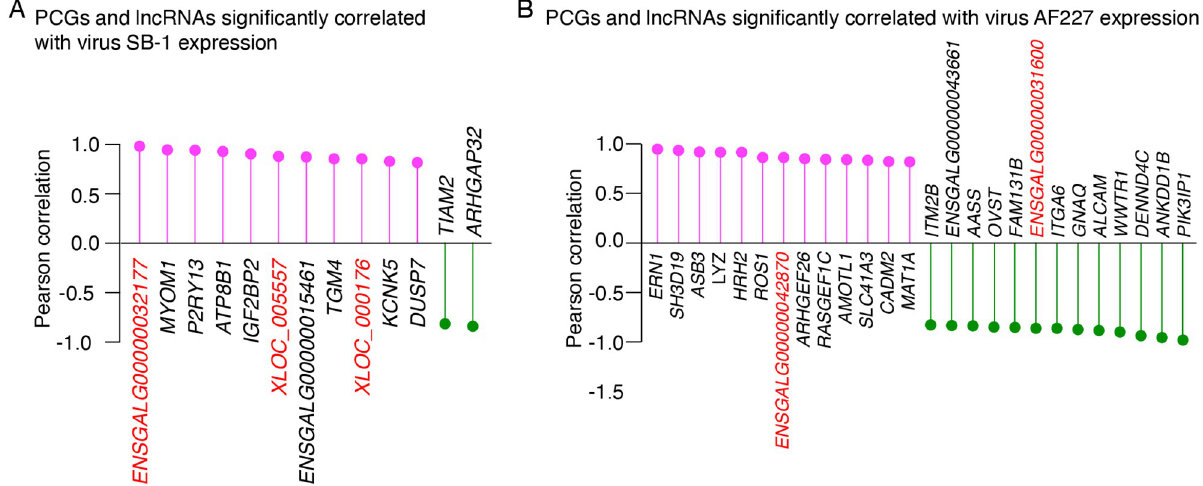
Fig 6. Protein coding genes and lncRNAs that were significantly correlated with virus (A) SB-1 or (B) AF227 expression. The number of RNA-seq reads mapped to each virus genome in each of the tumor samples were normalized to CPM and Pearson correlation between SB-1 and AF227 abundance and all the significantly differentially expressed genes was calculated in 6 tumor samples. p < 0.05 was used as the threshold to determine statistical significance. The lncRNAs are highlighted in red.